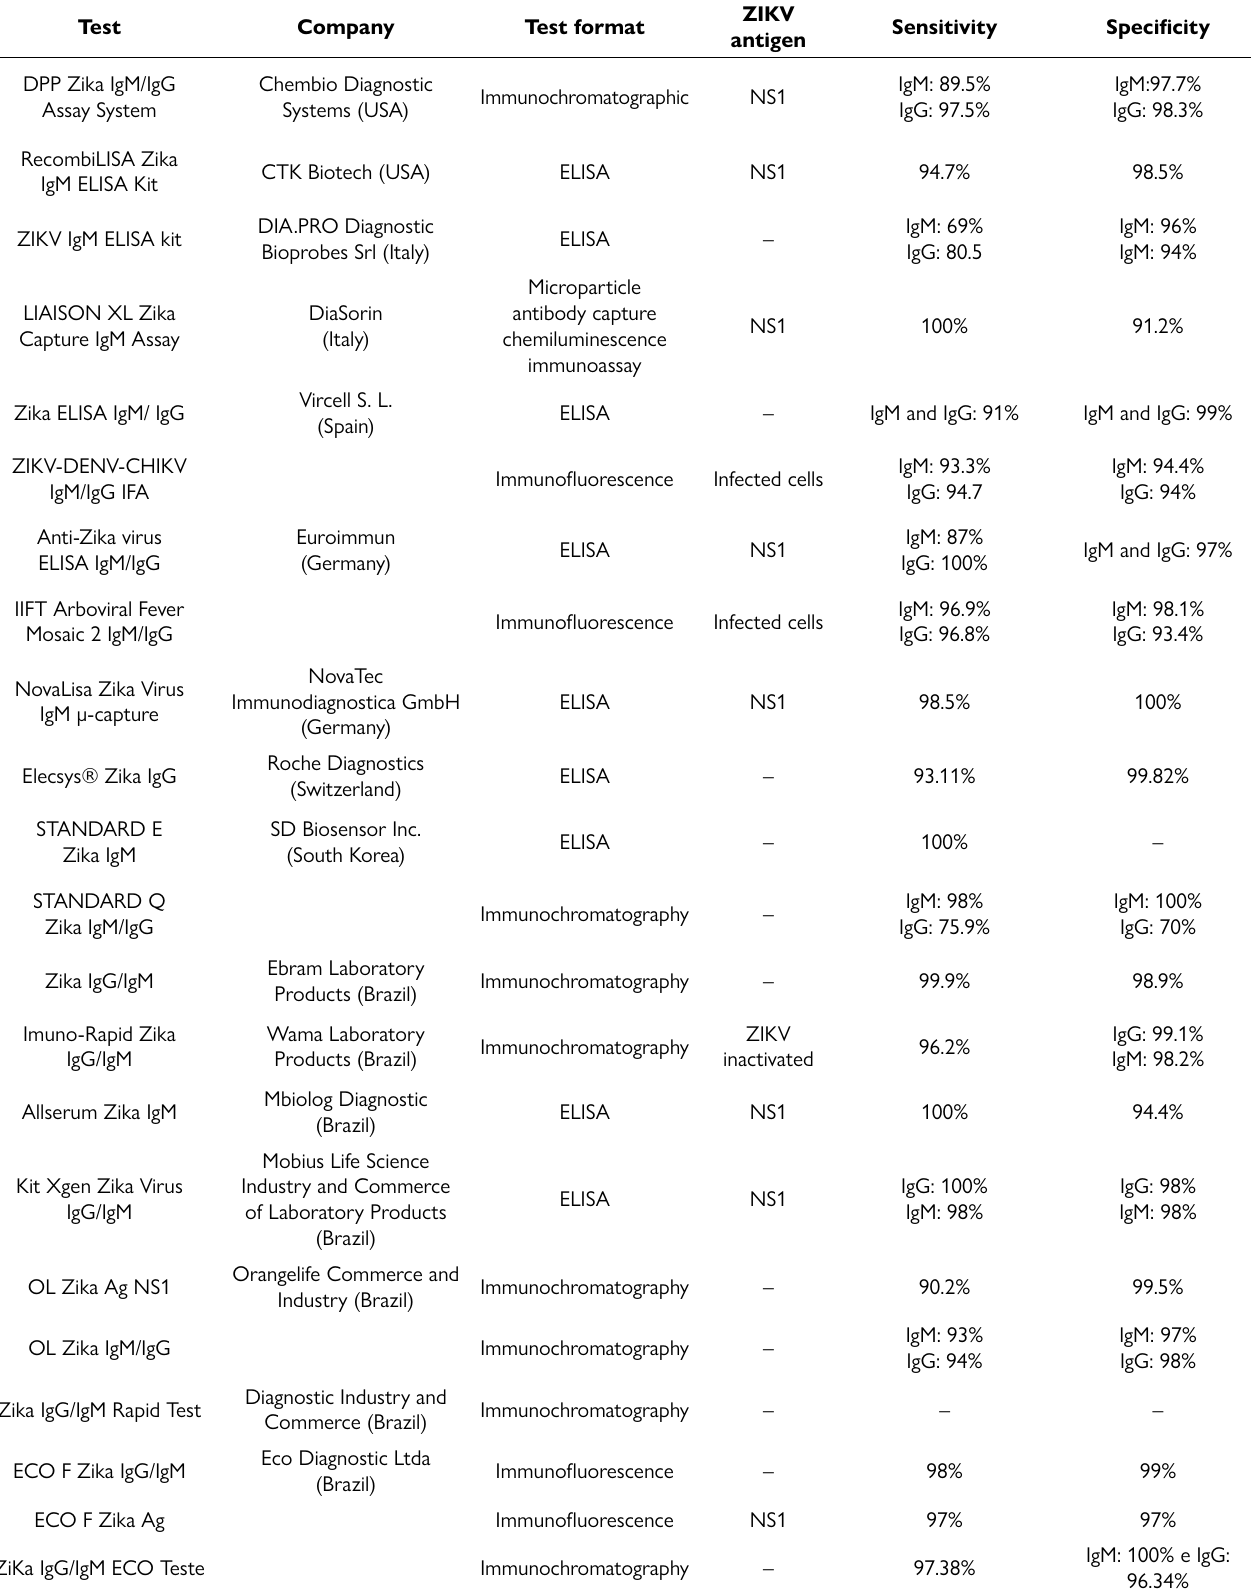
Table 1. Main currently approved ANVISA